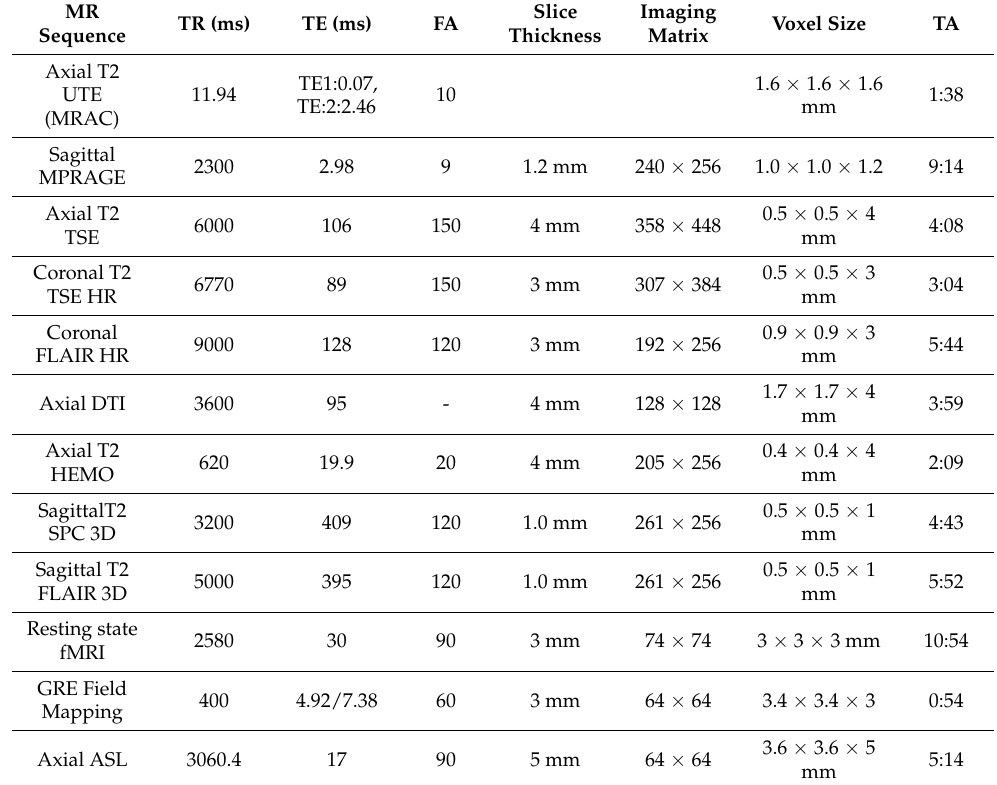
Table 1. Dedicated MRI epilepsy